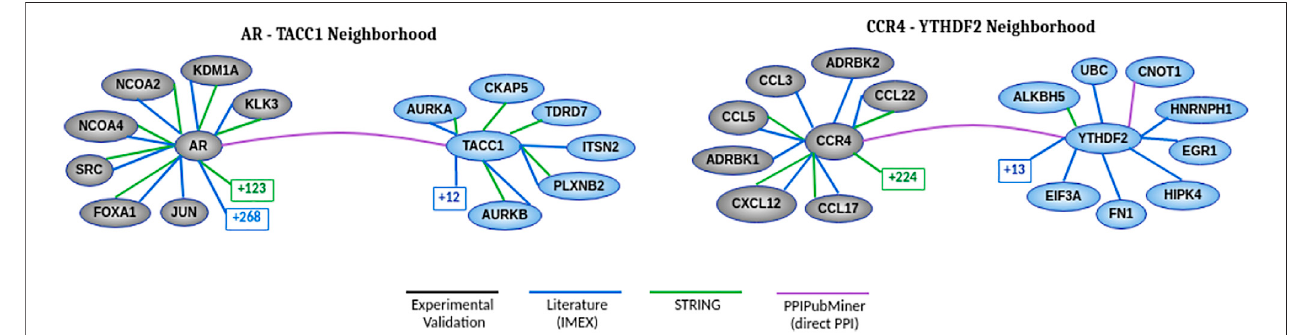
FIGURE5| Neighborhoodofeachproteinpairshowingtherelationsbetweenproteinsaccordingtoeachdatasource.Thenumberfoundinsquaresrepresentsthe number of hidden nodes that we set apart to improve clarity. The gray vertices represent the proteins known to be associated with cancer. The blue vertices are candidate proteins for such an association. The white vertices indicate the proteins connecting the blue and gray vertices in more than one data source. The known interactions at the green edge were extracted from the STRING (Szklarczyk et al., 2018) database and we used a con fi dence score range above 900 to fi lter its interactions. The other known interactions were extracted from the experimentally validated (black edge) database (Rolland et al., 2014) and another one based on literature curation (Breuer et al., 2013) (IMEX - International Molecular Exchange Consortium, in blue edge). The PPIs of these two databases were retrieved using the Network Analyst tool (Zhou et al., 2019). The purple edge is based on our validation